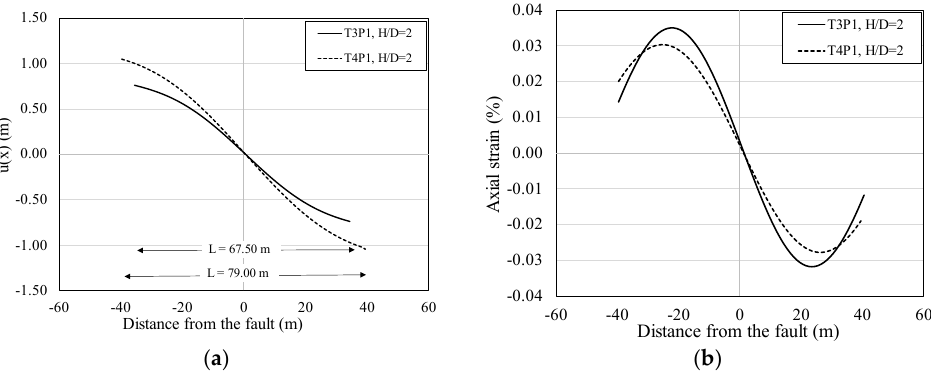
Figure 9. Comparison between the developed analytical model for the trenched pipeline and the analytical model for uniform seabed soil, T3P1 ( W = D) and T4P1 ( W = 1.3 D) with ( β = 0 ◦ ): ( a ) deformed pipeline shape, ( b ) distribution of axial strains along the pipeline.